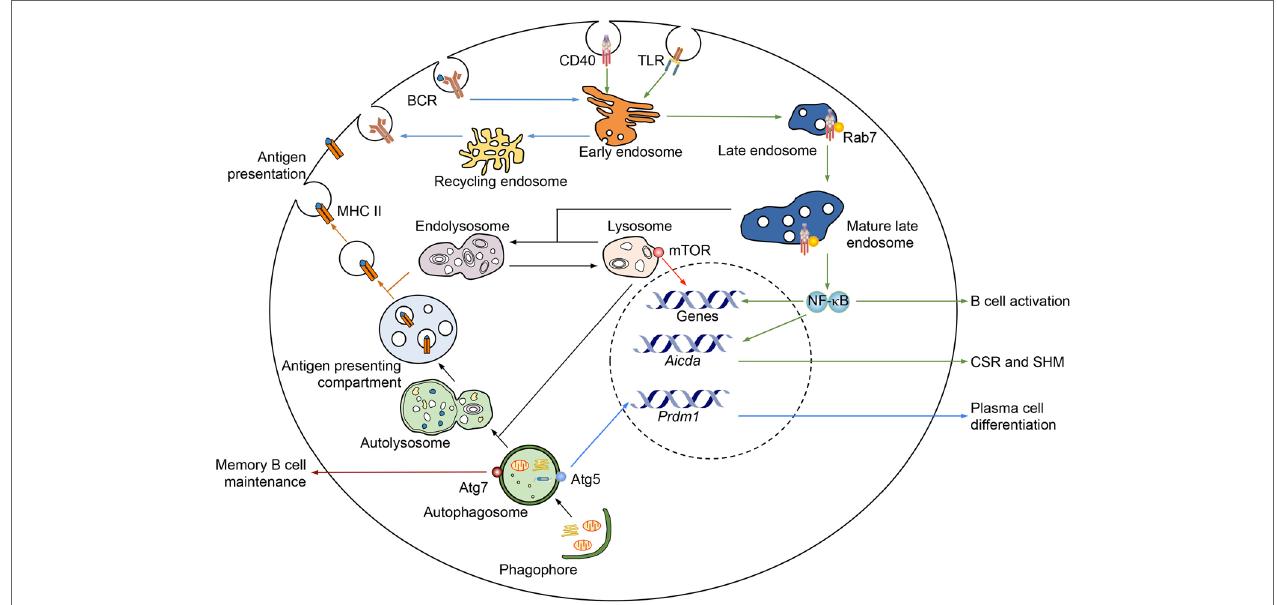
FiGURe 1 | Regulation of B cell differentiation and functions by intracellular membranes and associated proteins . Several B cell processes are regulated by endosomes, lysosomes, and autophagosomes. Upon antigen-triggered internalization, BCR is sorted by early endosomes to either recycle back onto the cell surface or go through antigen processing, which are mediated by endolysosomes, for the MHC II-dependent antigen presentation. Signaling receptors, such as CD40 (as depicted) and TLRs (both surface TLRs and intracellular TLRs), can be internalized and/or sorted by early endosomes to localize to mature late endosomes, as marked by Rab7. A Rab7-dependent process would stabilize the interaction of such receptors and their adaptors (e.g., CD40 and TRAF6), thereby promoting sustained signaling, such as NF- κ B activation, for induction of genes important for B cell activation and CSR/SHM, e.g., AID. Lysosomes, as transformed from and maintained by mature late endosomes, can recruit mTOR, which plays an important role in B cell activation. Autophagosomes are important for memory B cell maintenance, i.e., through Atg7, and plasma cell differentiation and survival, e.g., through Atg5. They can also fuse with lysosomes to become autolysosomes, which then transform into a specialized compartment for antigen